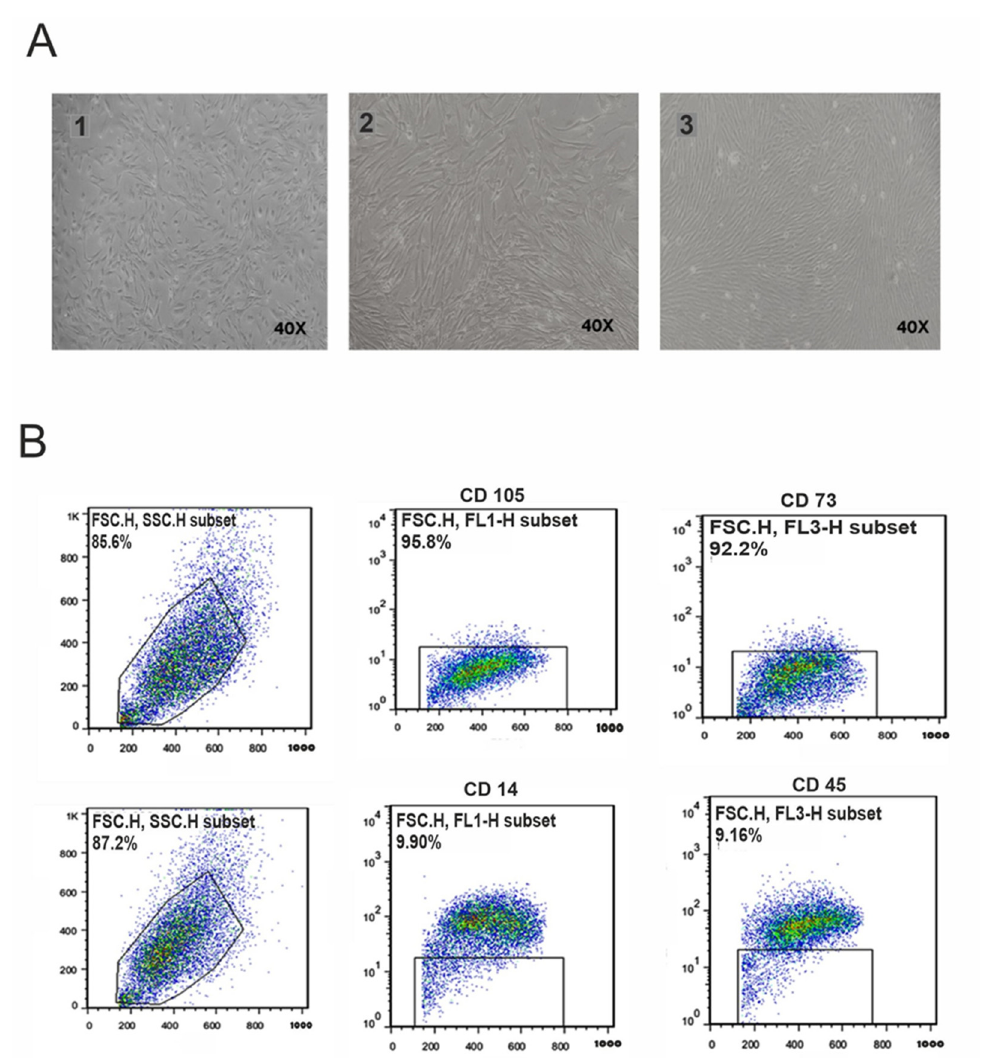
Figure 2. Cultivation and characterization of MSCs. ( A ) 1 shows P0 of cells after one week of the first culture; 2 shows P1 of cells after three days; 3 shows P1 of cells after one week (40 × magnification was used). ( B ) Flow cytometry of hAF-MSCs for surface markers. Expression of surface markers detected by flow cytometric analysis in P4 of MSCs, with CD73 and CD105 as positive markers and CD14 and CD45 as negative markers for hAF-MSCs.